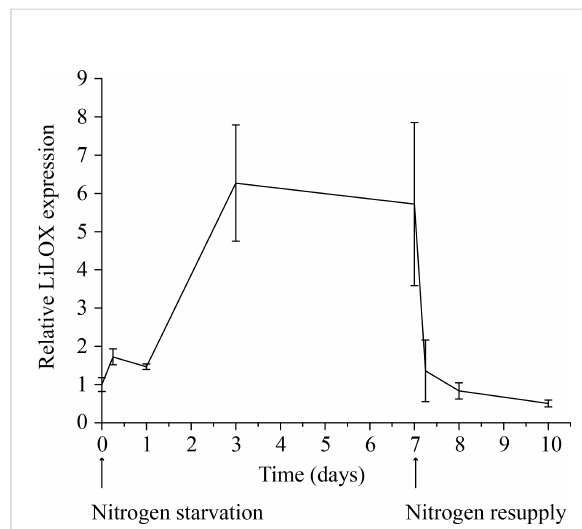
FIGURE 1 Transcript level of LiLOX during nitrogen starvation. Cultures of L. incisa were grown in full BG11 media. The cells were then split in six different cultures, three with full BG11 medium and three without any nitrogen source. Cells were collected at different time points, and RT-qPCR was performed to measure the transcript level of LiLOX and ribosomal protein S21 as control. The graph shows the difference of LiLOX expression after nitrogen starvation compared to growth in full media, normalized to the reference gene. Error bars represent the standard deviation of the three samples grown in